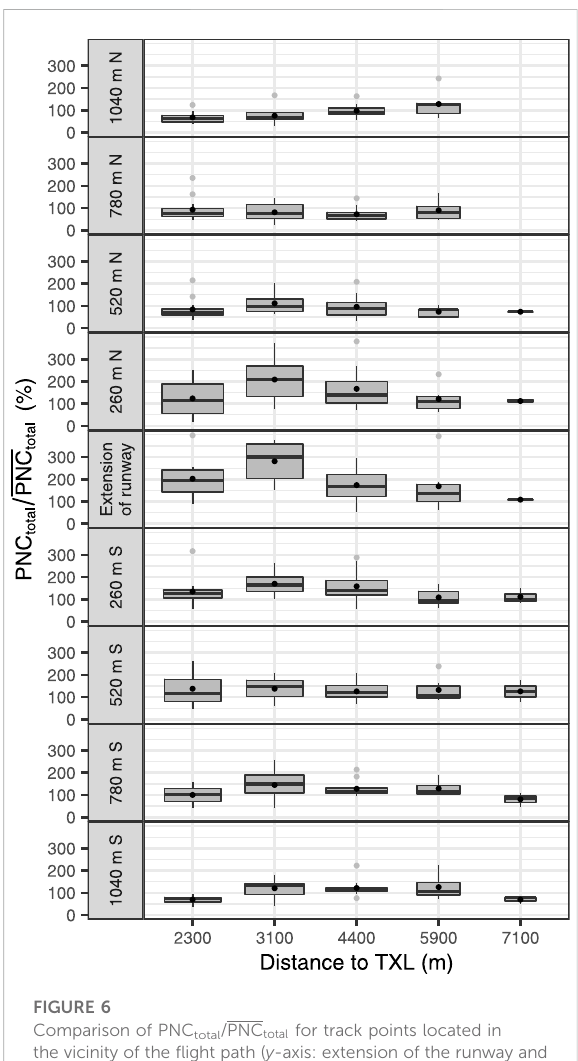
FIGURE 6 Comparison of PNC total /PNC total for track points located in the vicinity of the fl ight path ( y -axis: extension of the runway and the adjacent areas north and south) at the transects of the measurement route with the fl ight path at various distances from the airport. Distances are labeled as averages per transect